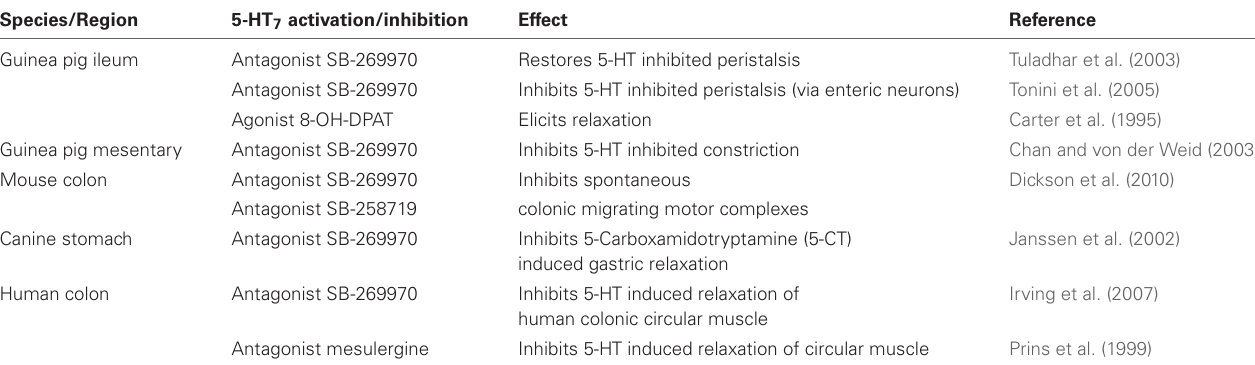
Table 1 | Effects of 5-HT 7 receptor activation or inactivation on gut function